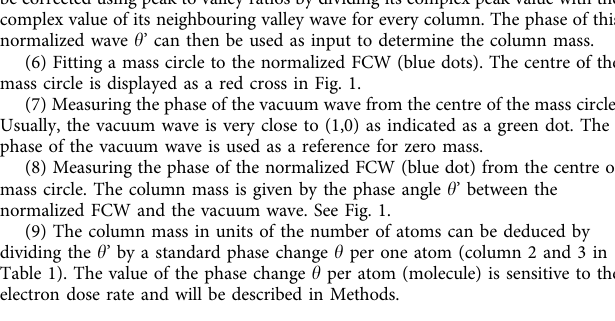
Table 1). The value of the phase change y per atom (molecule) is sensitive to the electron dose rate and will be described in Methods. Determination of the defocus of a column . We back propagate the exit wave function numerically by convolution with an inverse defocus operator. In this process, every spherical wave is refocused backwards into its point of origin where the intensity is maximal. This position can be obtained by monitoring the intensity of the back-propagated wave as a function of the propagated distance. The exit wave function was propagated (defocused) in both positive and negative directions, and for each column the intensity at every focus positions was recorded and forms a 3D ( x , y , D f ) intensity stack along the focus axis. We applied this to the cases of Ge [110], MgO [100] and Au [110]. Some cross-sections of defocused intensity stacks are displayed in Fig. 7a–c, respectively. All local column intensities of the waves show an elongated ellipsoidal shape (left in Fig. 7). The intensity profile (right in Fig. 7) along the centre of the ellipsoid are also given to show the dif- ference in ‘ z ’ height of the exit surface. However, the ellipsoid always exhibits a ‘flat’ intensity maximum, which limits the depth precision.